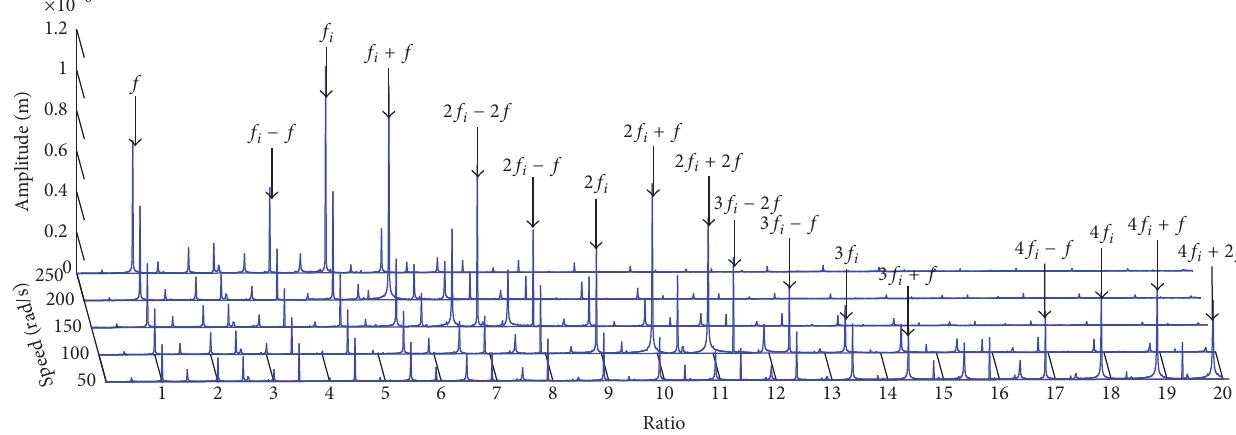
Figure 7: Waterfall plot of inner race defect bearing system with speed at width 1𝑒 − 3 m.